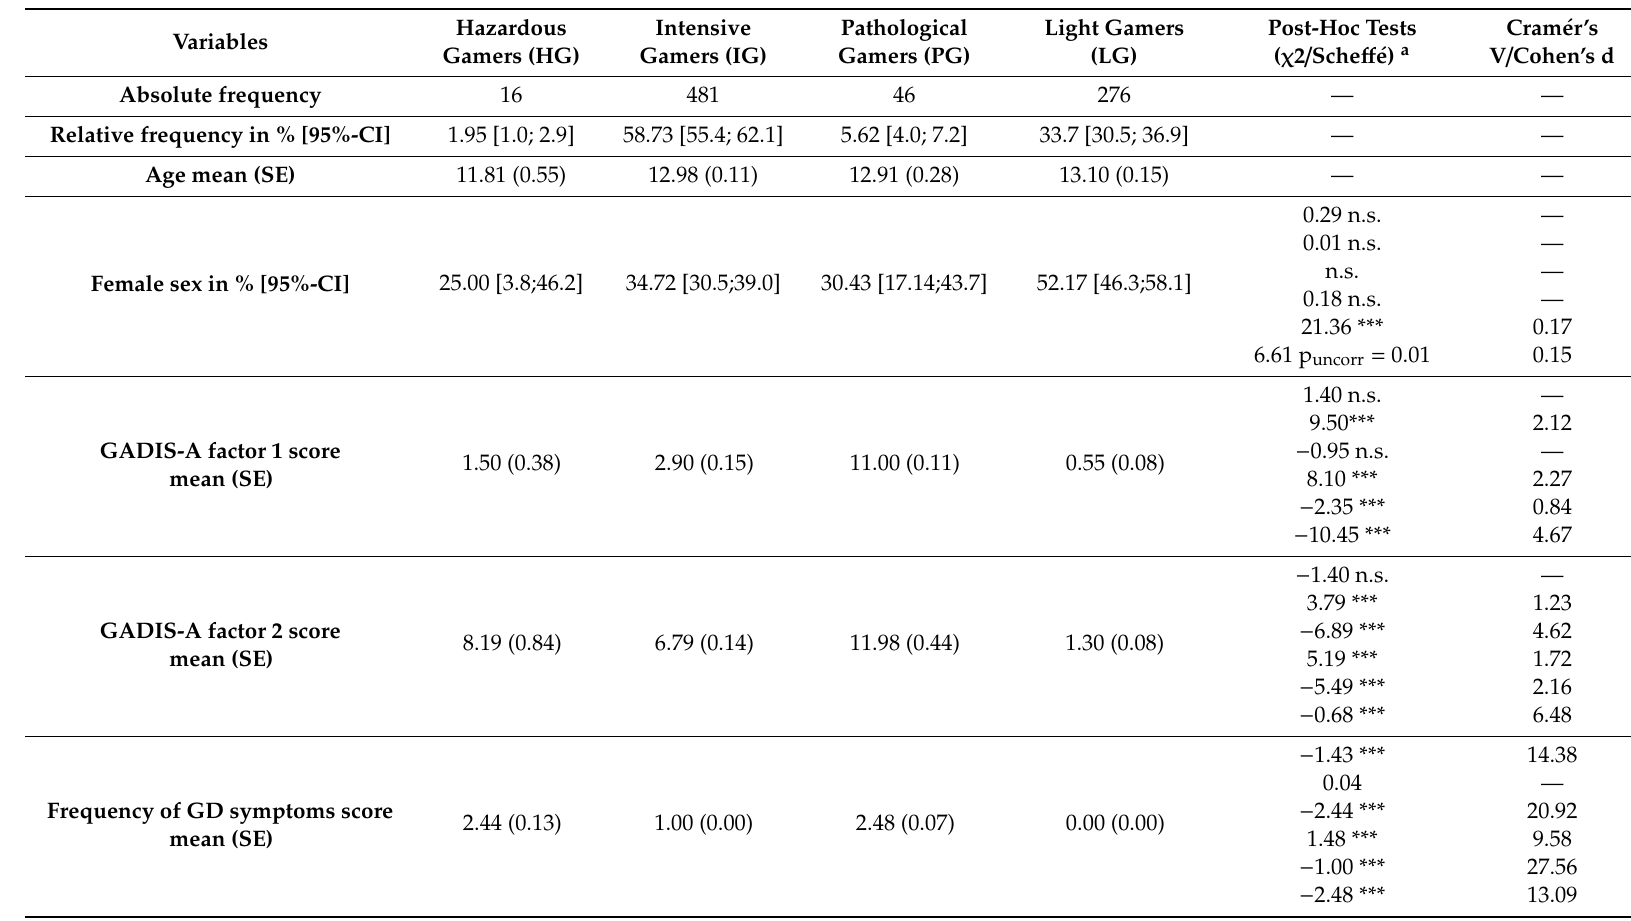
Table 5. Post-hoc MANOVA and between groups tests of gaming profiles according to Latent Profile Analysis (LPA).